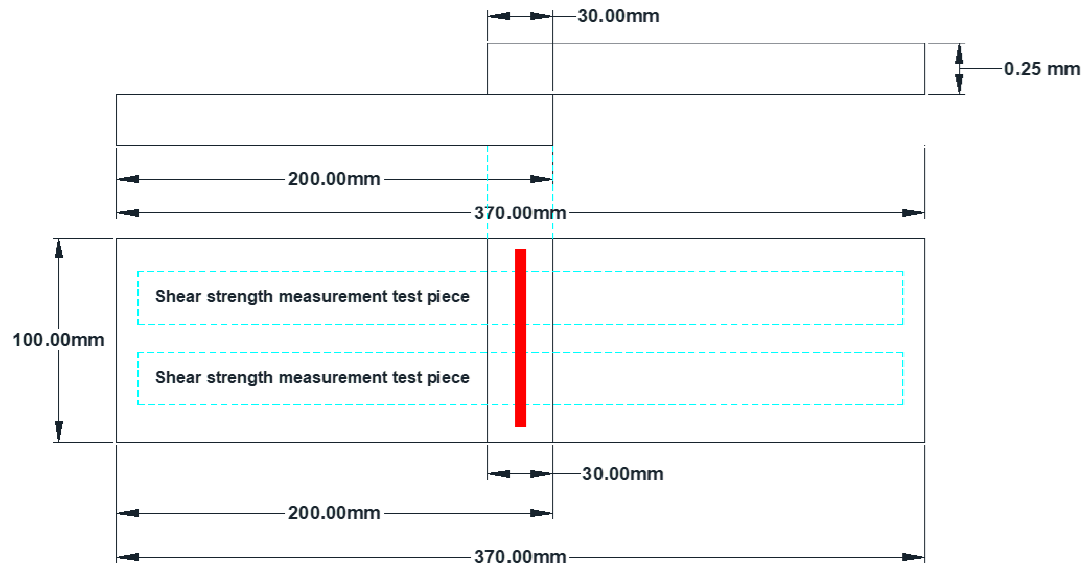
Figure 6. Tensile testing equipment.